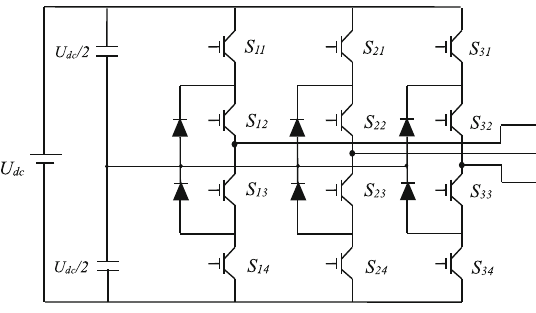
Fig. 3 Schema of three-level inverter with NPC structure